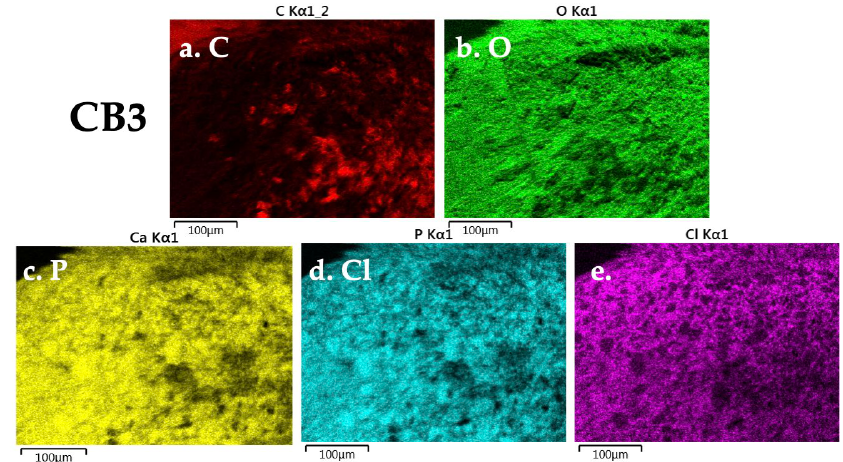
Figure A2. EDX identified elements for CB2: ( a ) C, ( b ) O, ( c ) Ca, ( d ) P, ( e ) Cl.